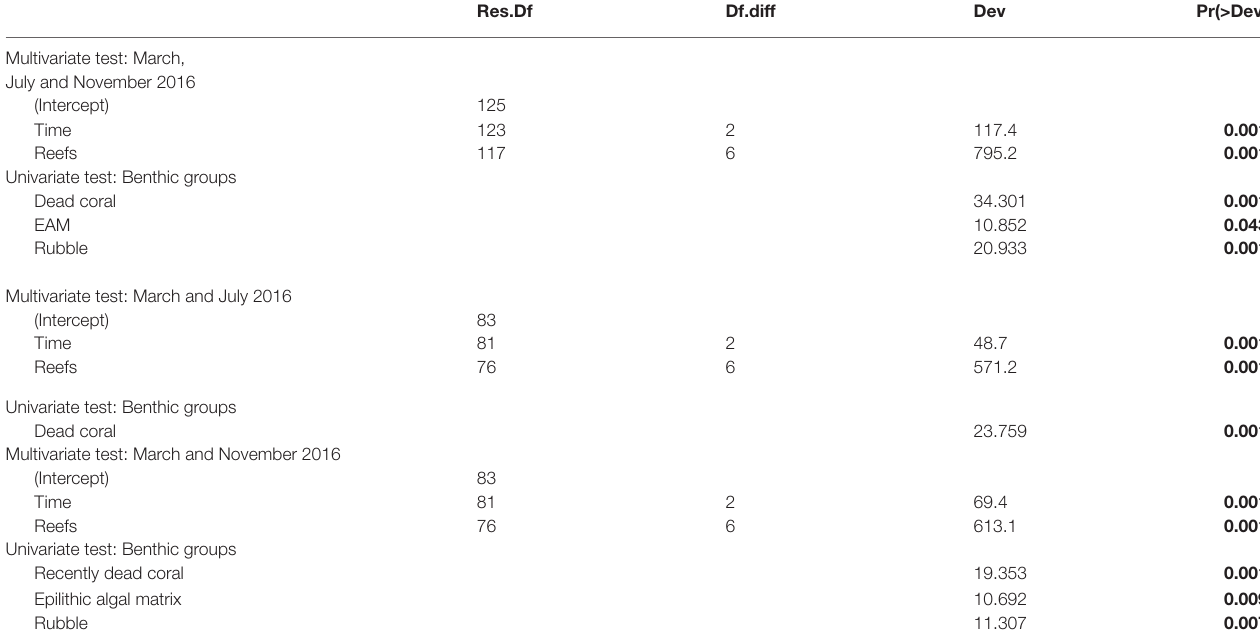
TABLE 1 | Summary statistics for analysis of benthic assemblages pooled among reefs across months (March, July and November